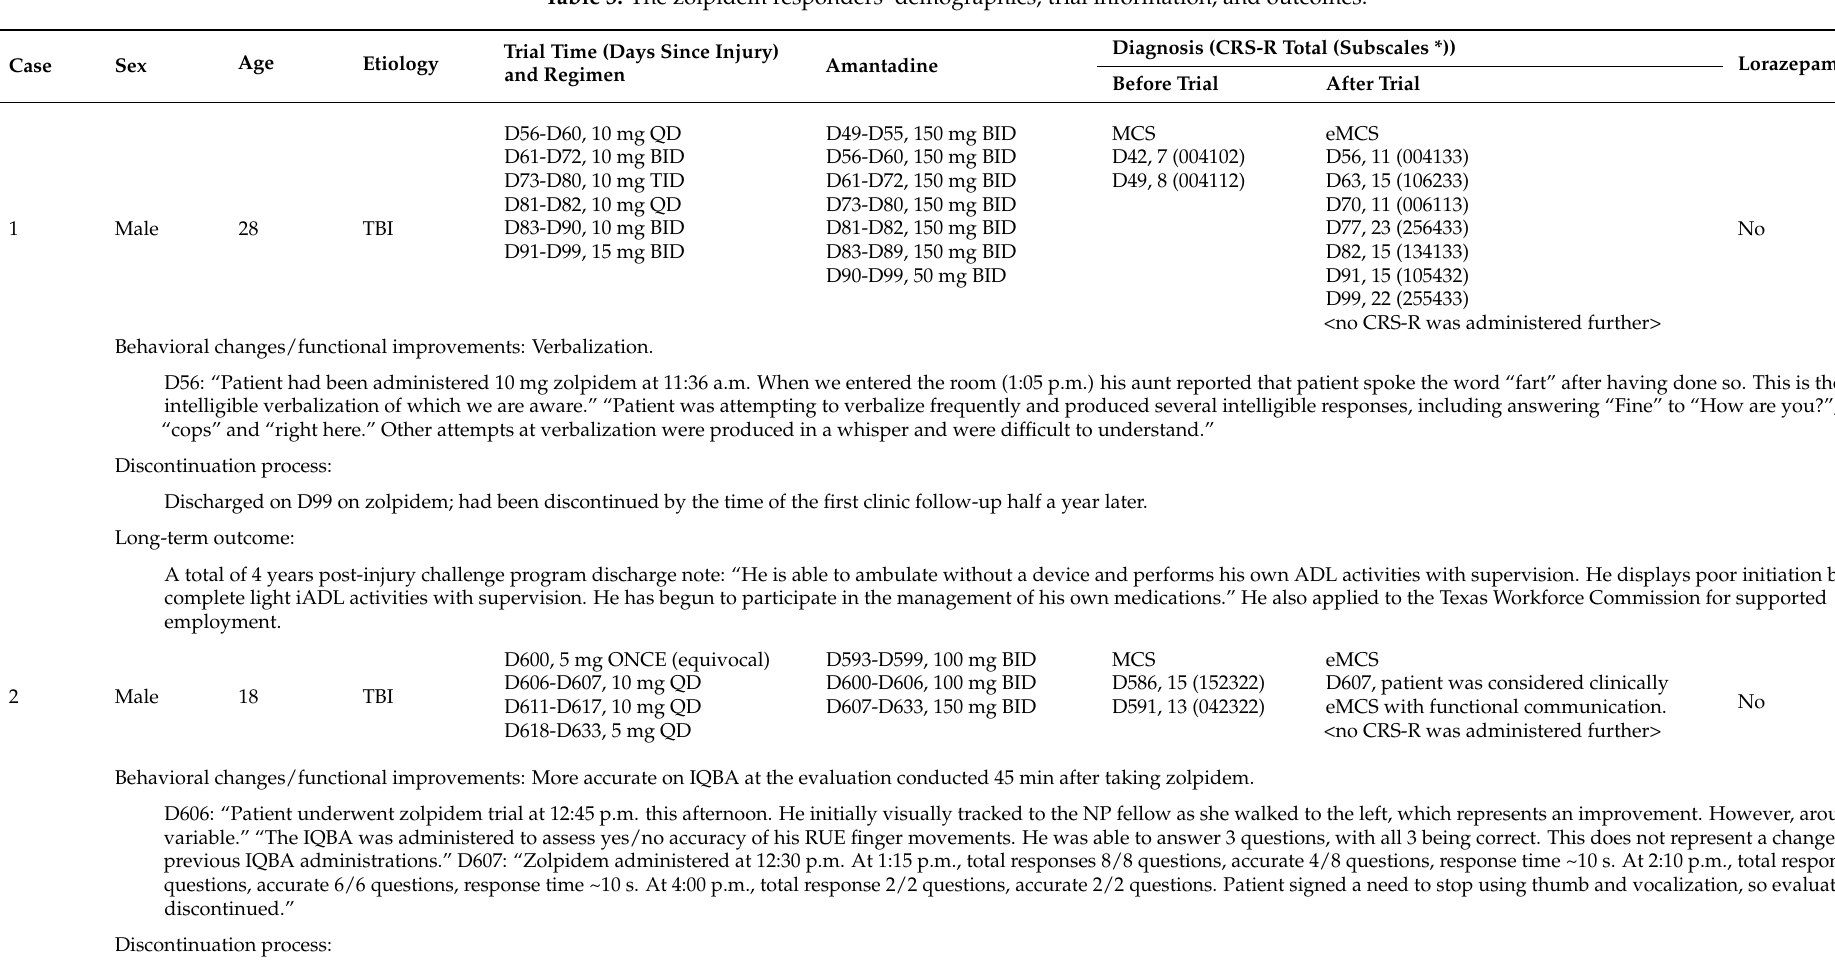
Table 3. The zolpidem responders’ demographics, trial information, and